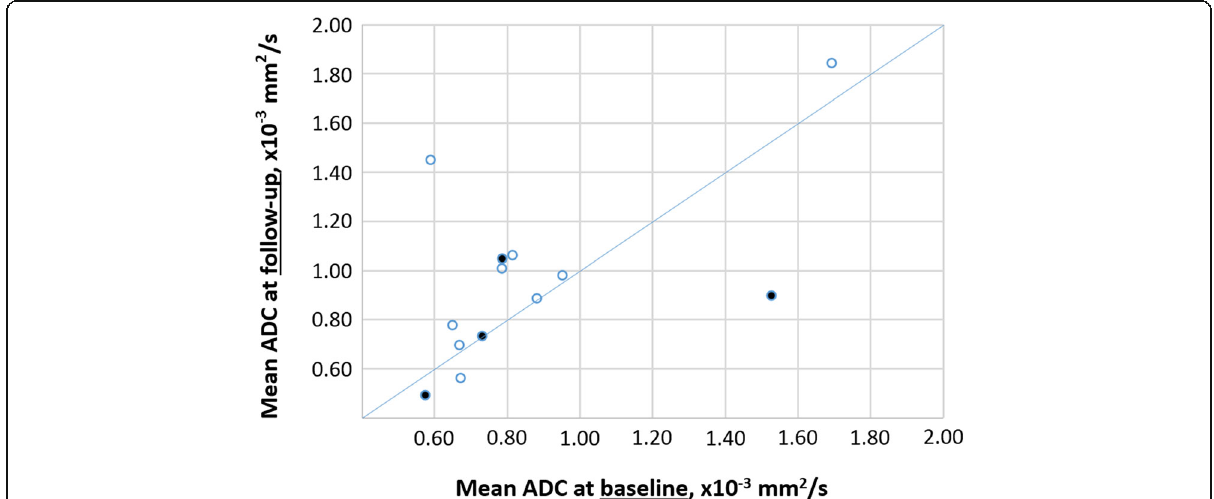
Fig. 5 Scatter plot of tumour ADC at baseline and on follow-up for 13 patients, including 11 patients with neuroblastoma (NB), one patient with ganglioneuroblastoma (GNB) and one patient with ganglioneuroma (GN). The filled markers indicate patients who suffered tumour relapse, the markers without filling represent patients without recurrence. Of three patients with falling ADC on follow-up ( below the line ), two had relapsing tumours (66%). In two patients with constant ADC ( on the line ), there was one recurrence (50%). Among eight patients with ADC increase on follow-up ( above the line ), only one tumour relapsed (13%)